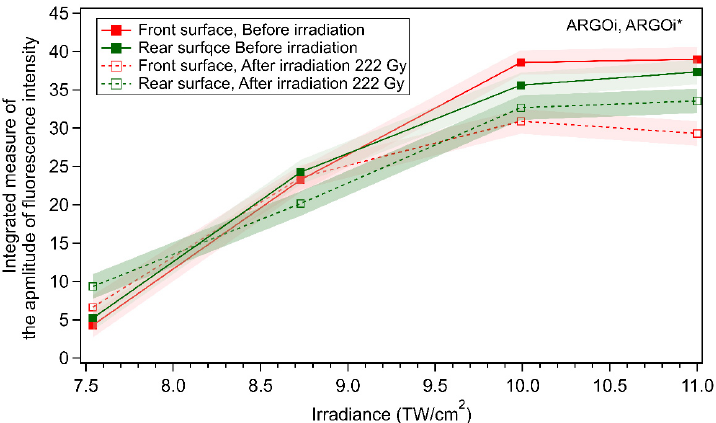
Figure 12. Integrated measure of the amplitude of fluorescence intensity for the different laser irradiance before and after 222 Gy-dose for the two planes in ARGOi and ARGOi* glass sample. The fluorescence intensity of the clusters decreases after X-ray irradiation in the two planes. After irradiation, the front surface presents less fluorescence emission than the rear one due to having less excitation available for the clusters of the front surface compared to those in the rear one. Indeed, the front surface has been submitted to a larger X-ray dose deposition than the rear one. The creation of a large number of color centers in the front surface attenuates the excitation light at 365 nm as well as the emitted light while passing through the same thickness to reach the surface. Oppositely, greater fluorescence excitation is available for the irradiated clusters of the rear surface, because such a 365 nm excitation is less absorbed thanks to the smaller amount of color centers generated by the X-rays. Moreover, the emitted light of those clusters is even less absorbed while passing through the same thickness. Note that these generated color centers are stable at room temperature.